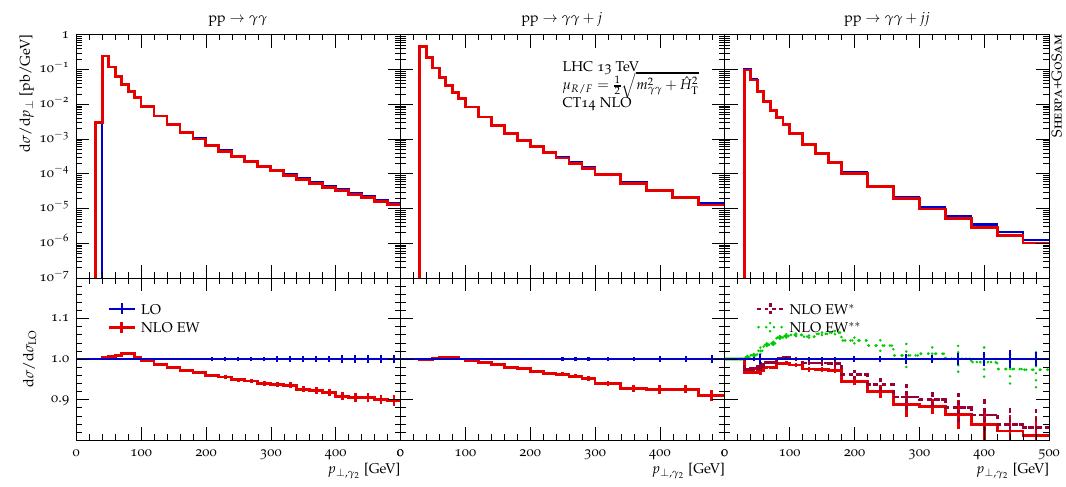
Figure 5 . The transverse momentum of the subleading isolated photon in (cid:13)(cid:13) + 0 ; 1 ; 2 jets pro- duction at 13 TeV at the